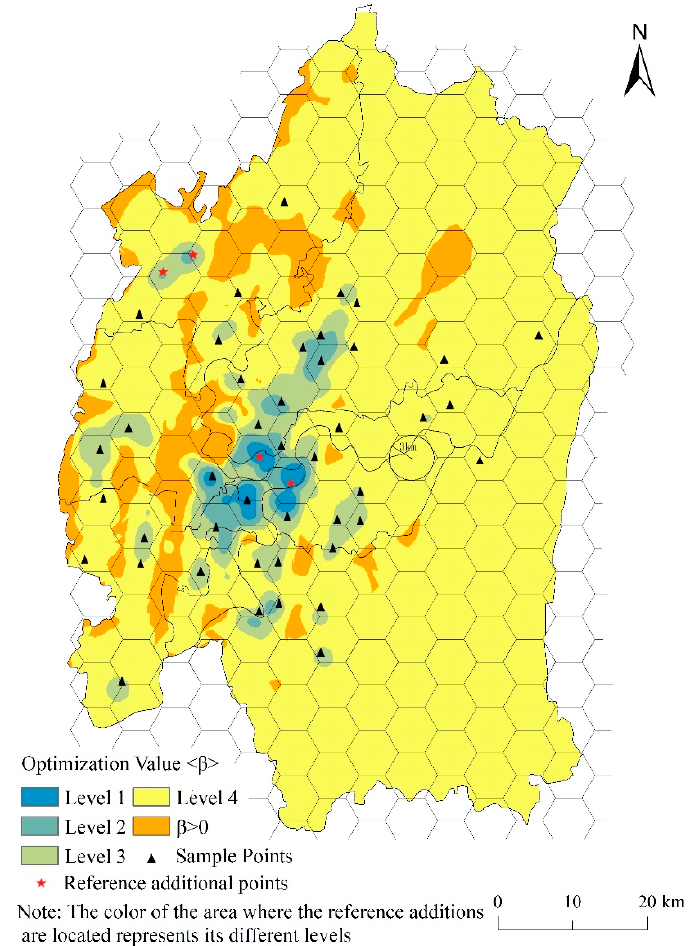
Figure 7. Electric vehicle charging infrastructure layout optimization reference map.